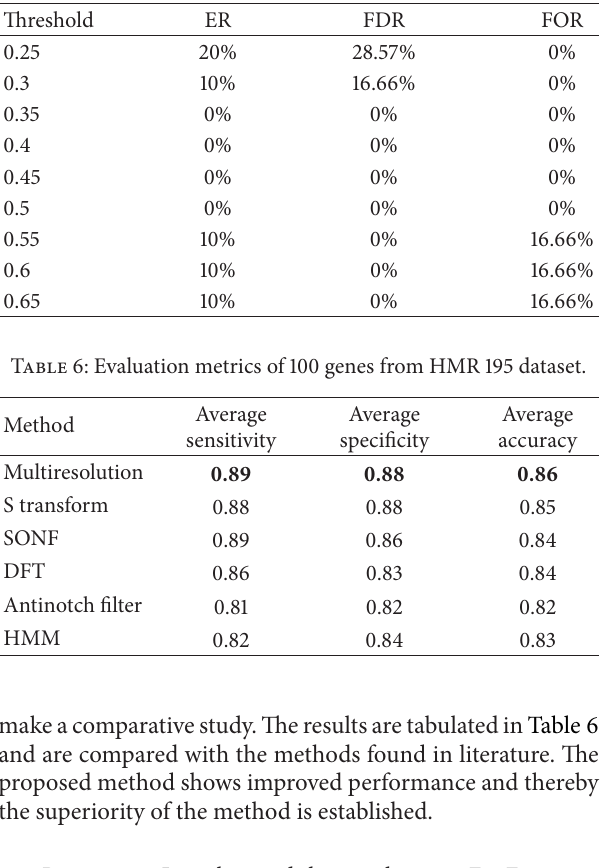
Table 5: Evaluation metrics of the gene F56F11.4 .